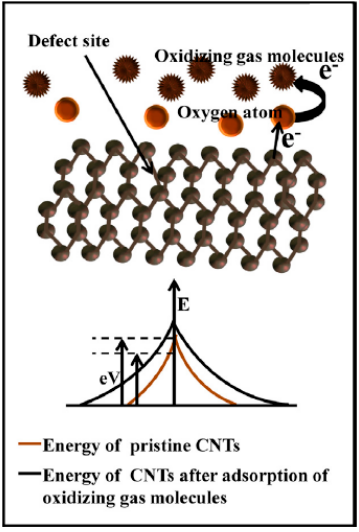
Figure 9. Sensing mechanism for carbon dioxide molecule. Reproduced with permission from Reference [13]. CNT: carbon nanotube.